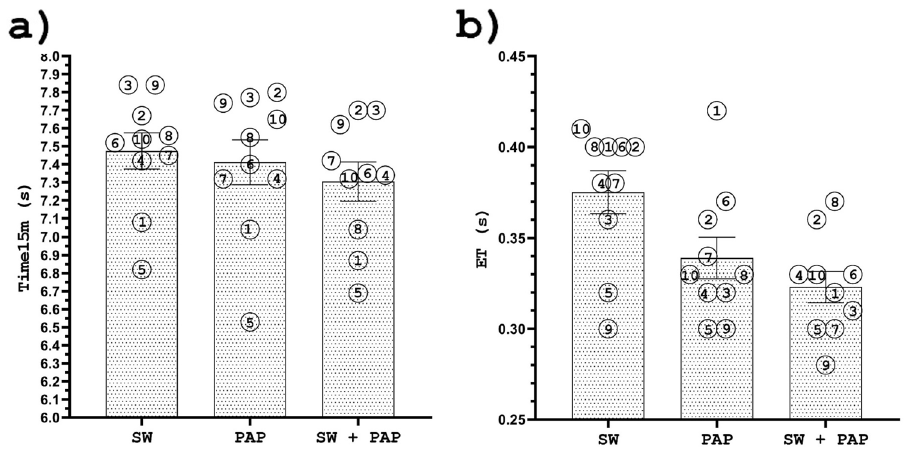
Figure 3. Individual responses for the swim start at 15 m ( a ) and entry time ( b ) after a swim-specific warm-up (SW), PAPE, and swim-specific warm-up with PAPE (SW + PAPE). The numbers indicate the athletes’ IDs. The results are plotted as mean ±